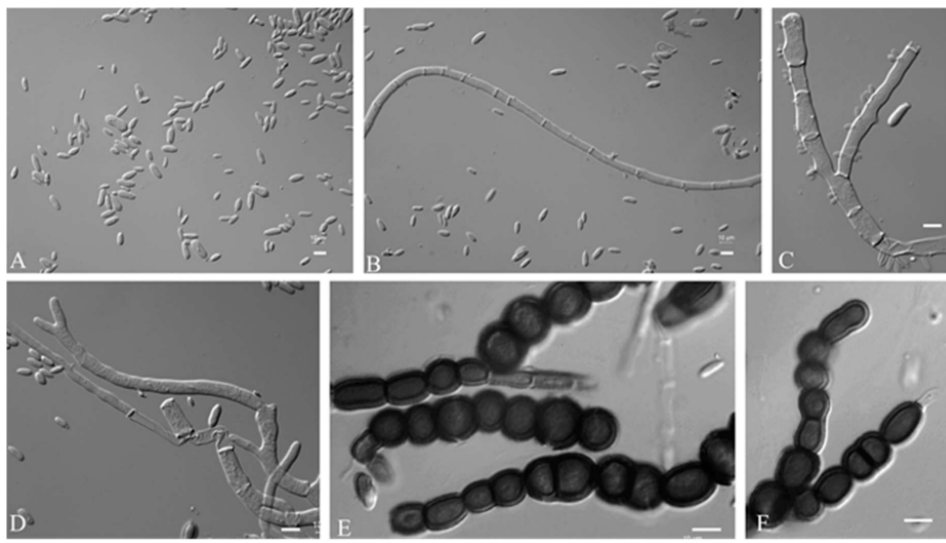
Figure 5. A. motuoense (CGMCC 2.7206 ex-type culture). ( A ): Conidia. ( B – D ): Hyphae and conidiog- enous cells. ( E , F ): Chlamydospores. Scale bars: ( A – F ) = 10 µm. 3.2.4. Aureobasidium intercalariosporum Q.M. Wang, F. Wu & M.M. Wang sp. nov.